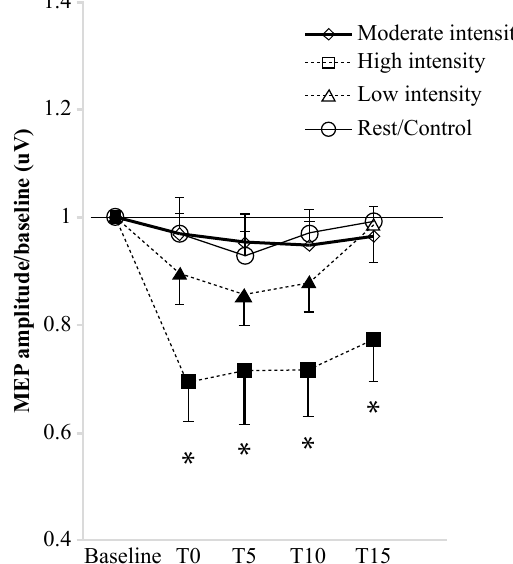
Figure 2. Intensity-dependent effects of physical exercise on cortico - spinal excitability. Shown are the mean (±SE) of baseline-standard - ized motor evoked potential (MEP) amplitudes before (baseline) and after (0, 5, 10 e 15 min) exercise/rest condition. Filled symbols indi - cate significant deviations of the post-exercise/rest MEP amplitudes from baseline values; *significant deviations of rest